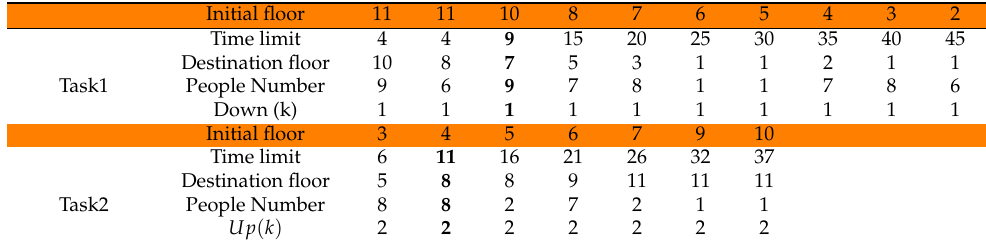
Table 2. Reservation tasks of 12-story building transported by double